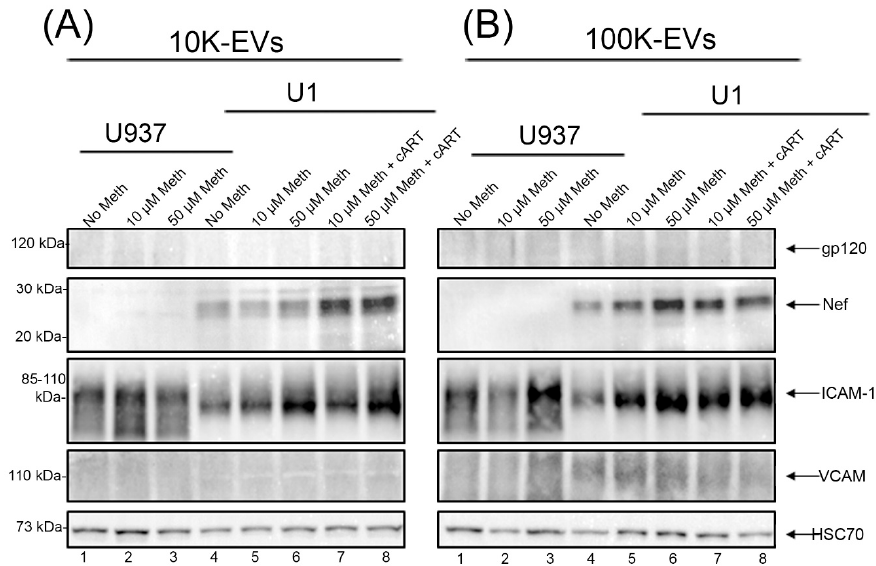
Figure 3. Impact of meth on EV cargo and expression of viral protein. Expression of HIV viral pro- teins gp120, and Nef, adhesion proteins: ICAM-1-, VCAM-, and EV-associated proteins HSC70 in 10 K ( A ) and 100 K ( B ) EVs isolated from meth-treated U937 and U1 cells culture supernatant.